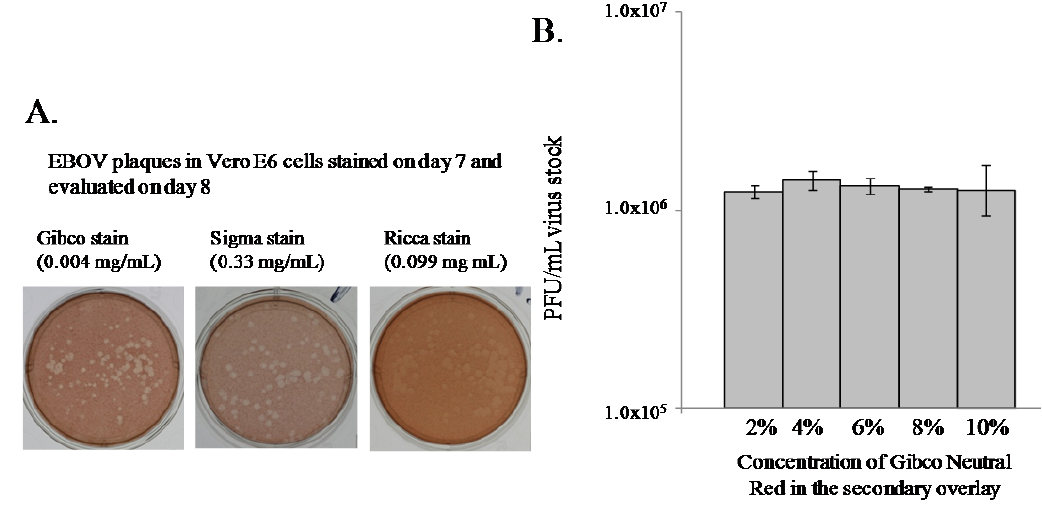
Figure 6. Gibco neutral red produced consistent results when tested at varying concentrations. ( A ) Three neutral red staining products provided different levels of staining quality. ( B ) Gibco neutral red produced consistent staining results when tested at varying concentrations. These experiments were performed twice with three replicates per